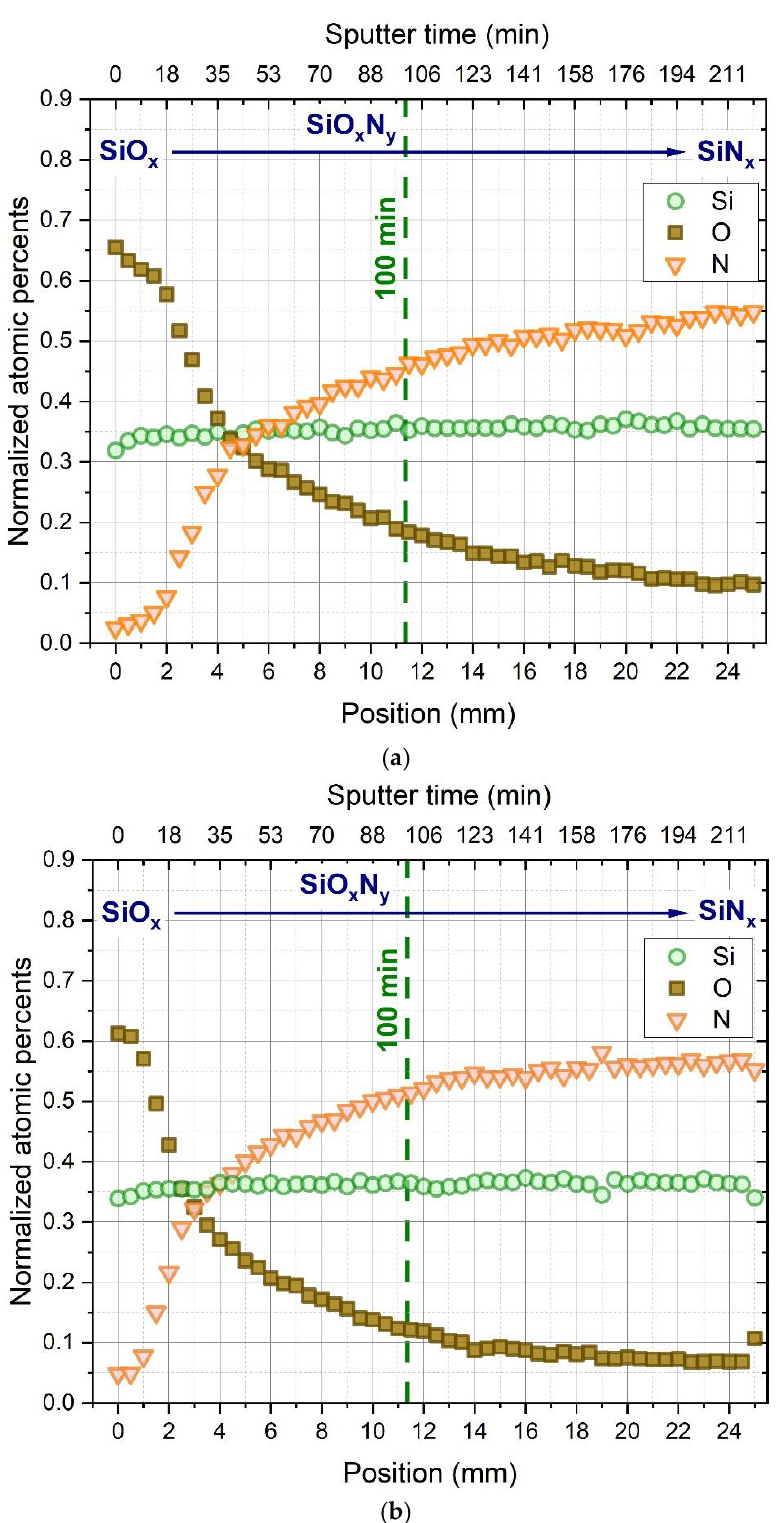
Figure 3. Atomic percentages of Si, N, and O along the composition spread samples deposited at ( a ) 1.62 kV and ( b ) 1.95 kV. The refractive index variations of the two samples at 632.8 nm measured by spectro- scopic ellipsometry are shown in Figure 4. It is clear that the refractive index increases as